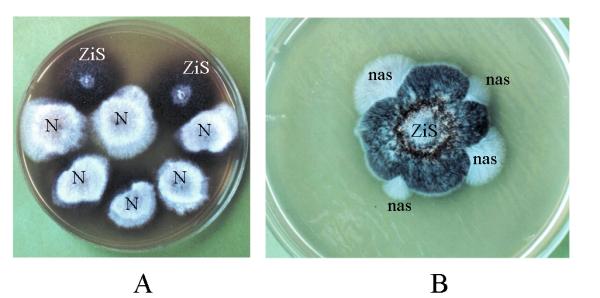
Selection of Nectria haematococca mutants affected in the expression of the Secteur. (A) Compares the morphology of a Normal growing culture (N) and of a ZiS culture (modified culture obtained by excision from a Secteur). (B) A 4-day ZiS culture submitted to UV mutagenesis. Note the emergence of four fast-growing sectors, which correspond to nas mutants.